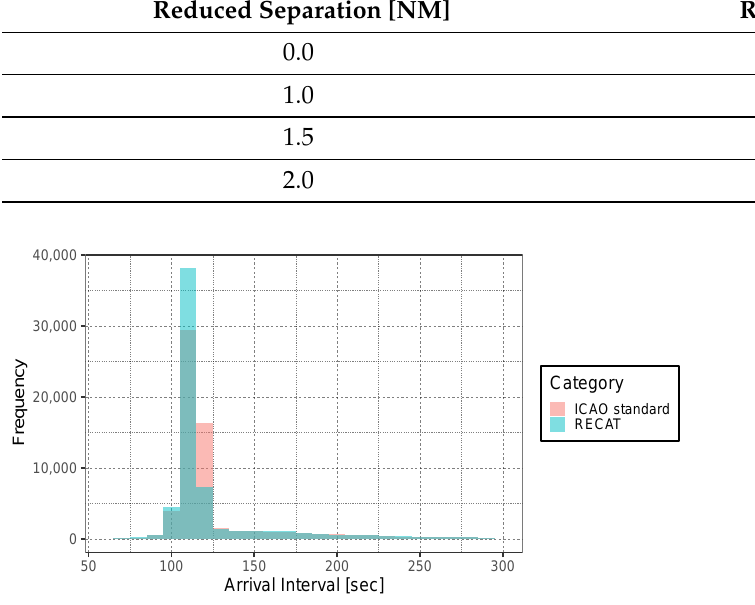
Figure 14. Comparing IAT at runway